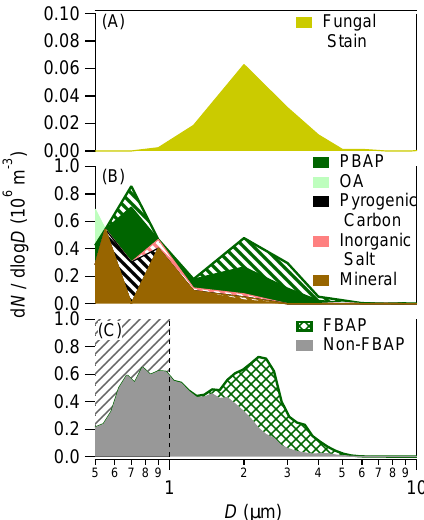
Fig. 6. Comparison of particle size distributions from three tech- niques: (A) lactophenol blue fungal (chitin) stain, (B) counts from SEM analysis, (C) UV-APS. Colored areas are stacked plots. For middle panel, regions of solid color indicate uncoated particles, di- agonal bars indicate particles coated with organic